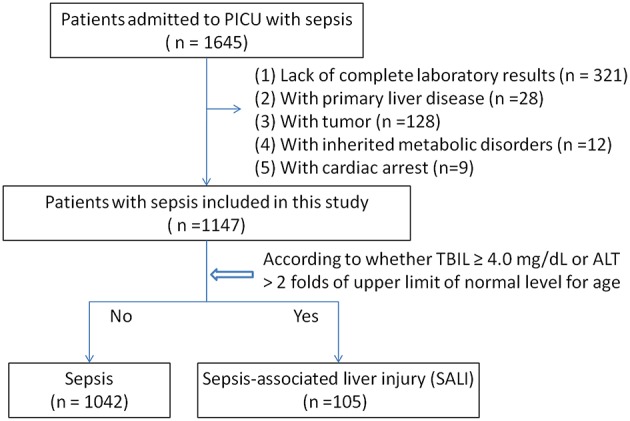
Flowchart of patients included in this study.